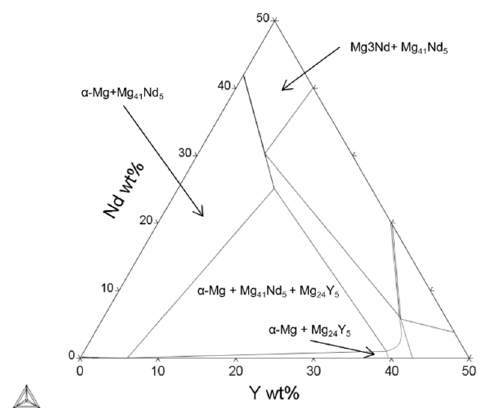
Figure 8. Calculated Mg-Y-Nd isothermal ternary phase diagram, T = 300 °C [49,50].